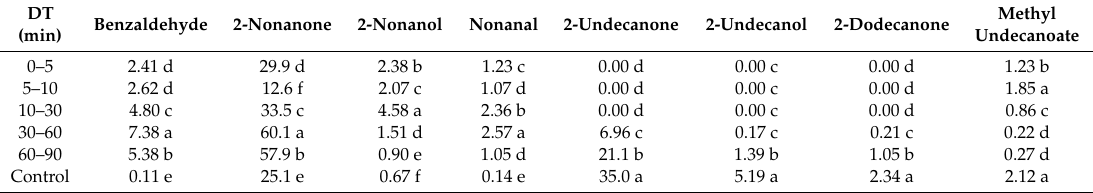
Table 3. The mean concentrations (%) of Ruta graveolens fruit EO (benzaldehyde, 2-nonanone, 2-nonanol, nonanal, 2-undecanone, 2-undecanol, 2-dodecanone, and methyl undecanoate) obtained from the six distillation times (DT). Control = nonstop 0–90 min.